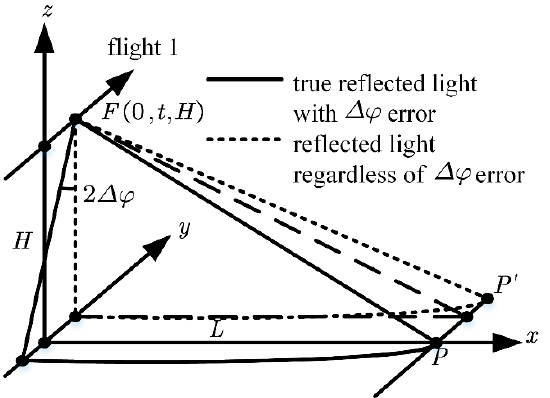
Figure 16. Schematic diagram of the simulation model of ∆𝜑 .